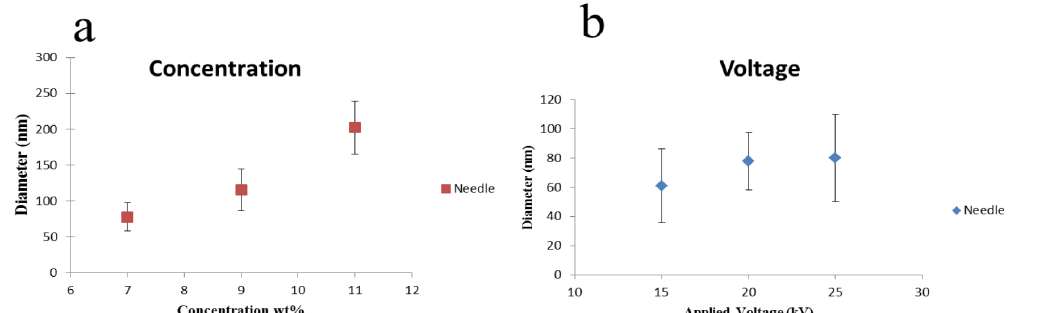
Fig. 4. Diameter of PAN nanofibers electrospun via needle system at different concentration (a) and applied voltage